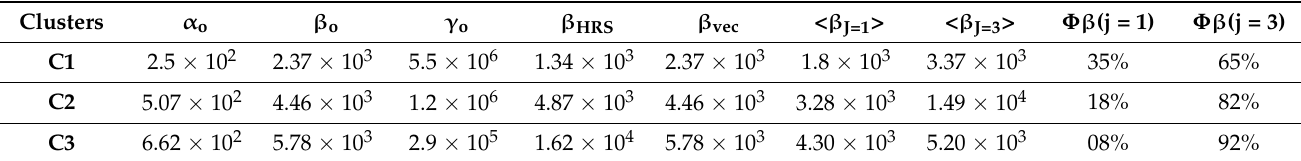
Table 4. Polarizabilities ( α o in au), hyperpolarizabilities ( β o in au), second hyperpolarizability ( γ o in au), scattering hyperpolarizability ( β HRS in au), vector part of hyperpolarizability ( β vec in au), average hyperpolarizability (< β J=1 > in au), average octupolar hyperpolarizability (< β J=3 > in au), % dipolar contribution to hyperpolarizability Φ β (j = 1), and % octupolar contribution to hyperpolarizability Φ β (j = 3) of C1 to C3